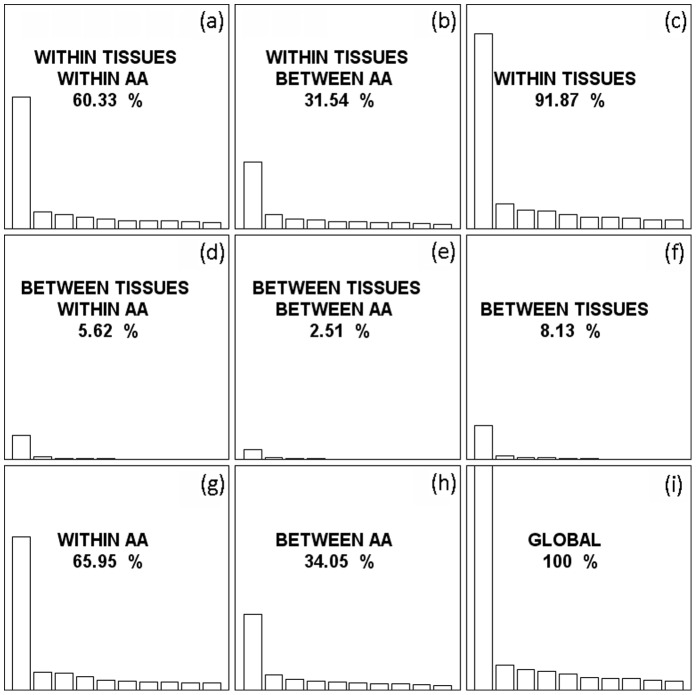
Internal correspondence analysis of tissue-specific genes in rice.The global codon usage variability was decomposed into within-block and between-block variability, consisting of the amino acid usage (between-AA) variability (b, e, h), synonymous codon usage (within-AA) variability (a, d, g), and variability of between- (d, e, f) or within tissues (a, b, c). The decomposition of global variability yields nine elementary analyses (a-i). In each peculiar analysis, the contribution to the total variance is indicated, where only the first 10 eigenvalues are represented to allow for a direct visual comparison.